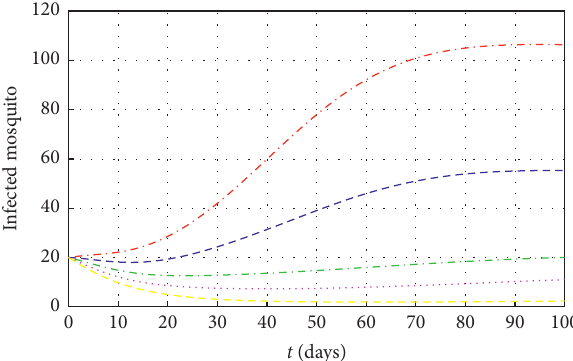
Figure 9: Population of infected mosquitoes with different biting rates (without awareness (red line); with low to high awareness rate (blue, green, magenta, and yellow